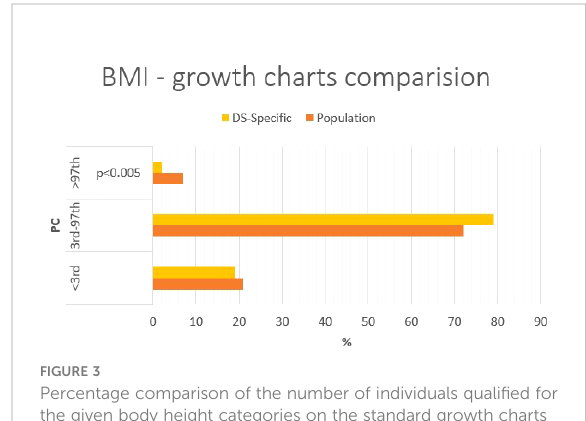
FIGURE 3 Percentage comparison of the number of individuals quali fi ed for the given body height categories on the standard growth charts and DS-specialized growth charts.